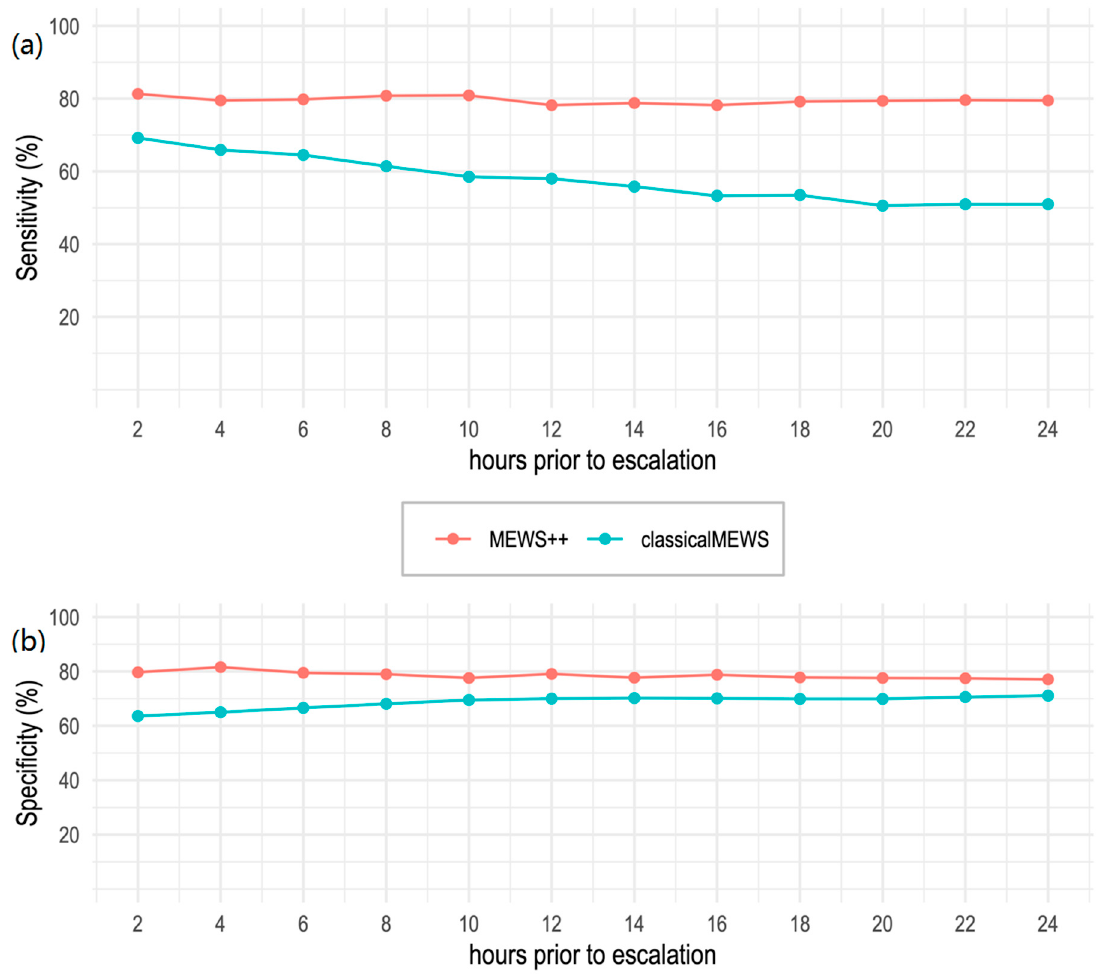
Figure 3. Comparison of 24-h performance of RF Model (MEWS ++ ) vs. classical MEWS. Predictions were generated every 2 h for 24 h prior to escalation. A threshold of 2 was used for MEWS, and 0.5 (the default) for the RF model. ( a ) Sensitivity of MEWS begins to degrade after 4 h whereas sensitivity of MEWS ++ remains stable. ( b ) Specificity of MEWS ++ is consistently higher than MEWS.